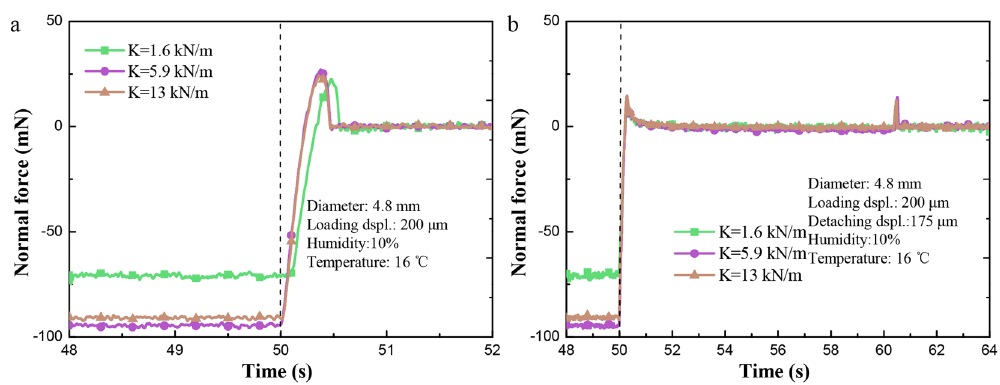
Figure 4. Force–time curves in OSD and TSD for different cantilever stiffness of 1.6, 5.9, 13 kN/m, respectively, with the humidity of 10% and environment temperature of 16 degrees Celsius. ( a ) Curve in OSD and a loading displacement of 200 μ m with different cantilever stiffness (diameter D = 4.8 mm, detaching velocity v = 625 μ m/s); ( b ) Curve in TSD, first detaching displacement of 175 μ m and a loading displacement of 200 μ m with different cantilever stiffness (diameter D = 4.8 mm, detaching velocity v = 625 μ